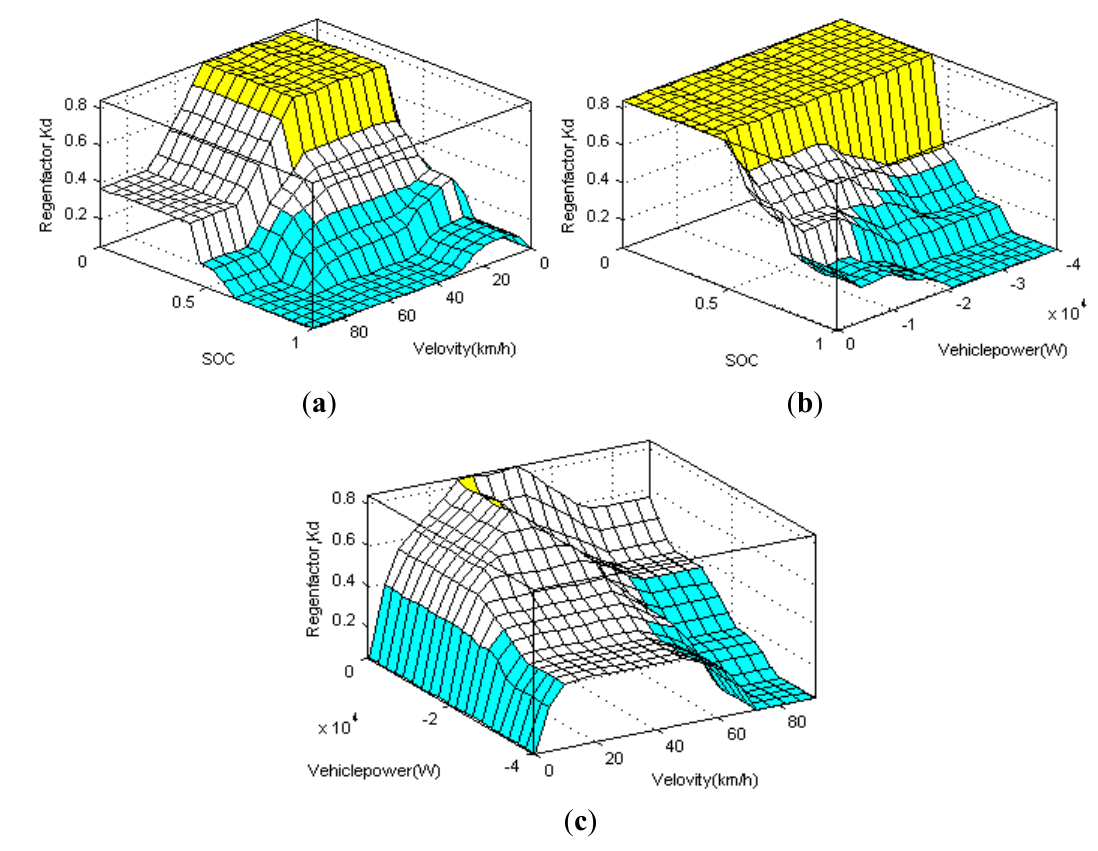
Figure 4. Surface plot for the regenerative FLC variables: ( a ) Effect of SOC and vehicle velocity on (cid:1837) ; ( b ) Effect of SOC and vehicle power on (cid:1837) (cid:3031) and velocity on (cid:1837) (cid:3031)